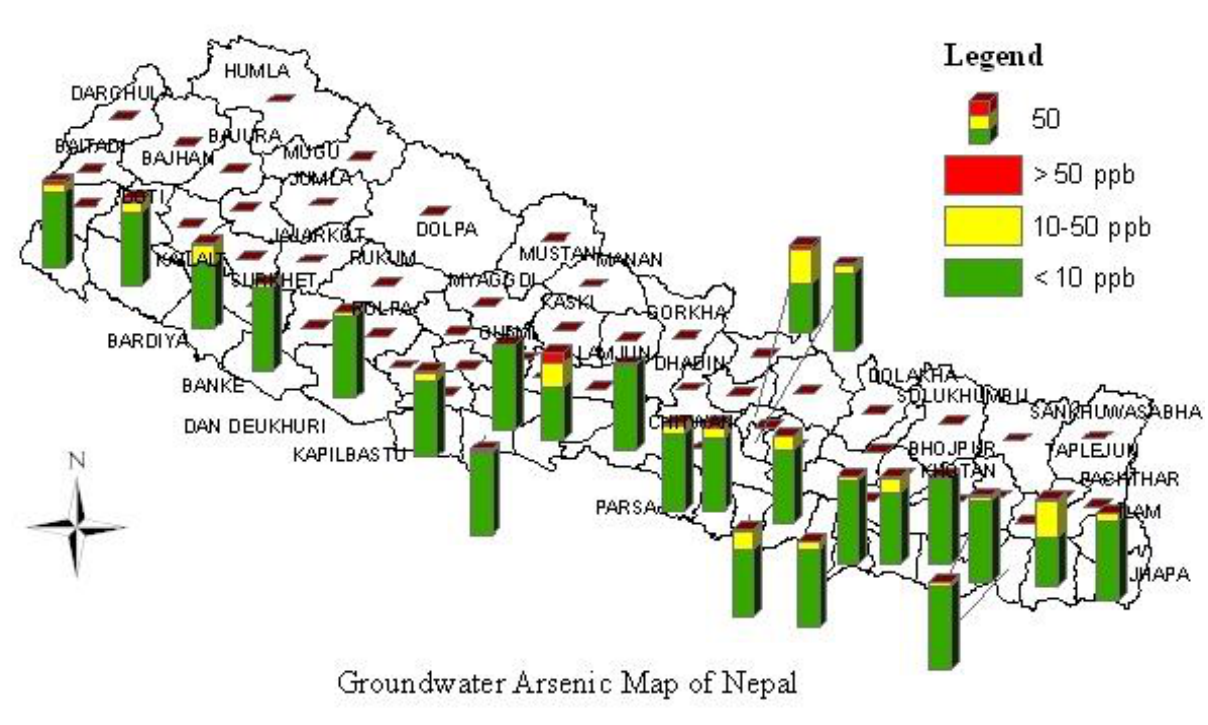
Figure 3. Groundwater arsenic map of Nepal showing proportion of arsenic contaminated samples found in various districts of